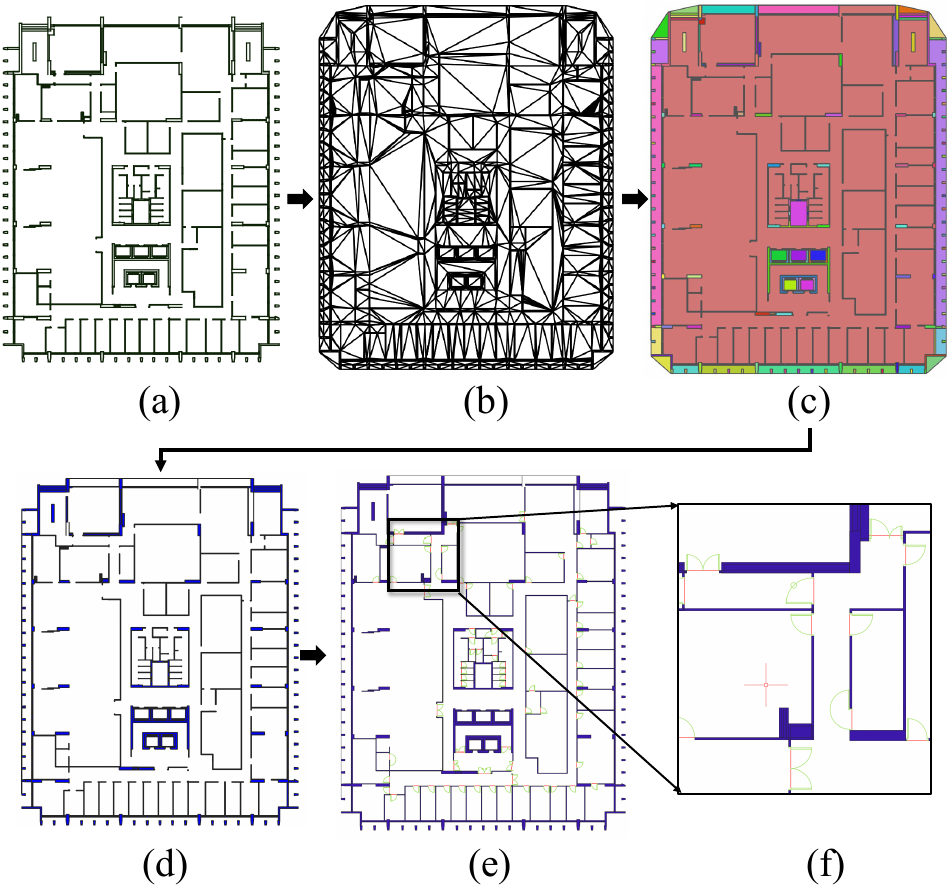
Figure 3. Polygonization of 2D story plan based on CAD drawings. ( a ) Filtered segments of vertical structures; ( b ) triangles by constraint triangularization; ( c ) merged polygons; ( d ) filtered and filled polygons of structures; ( e ) simplified door symbols connecting walls; ( f ) details of simplified doors, where the green lines are the original symbols and the red ones are simplified